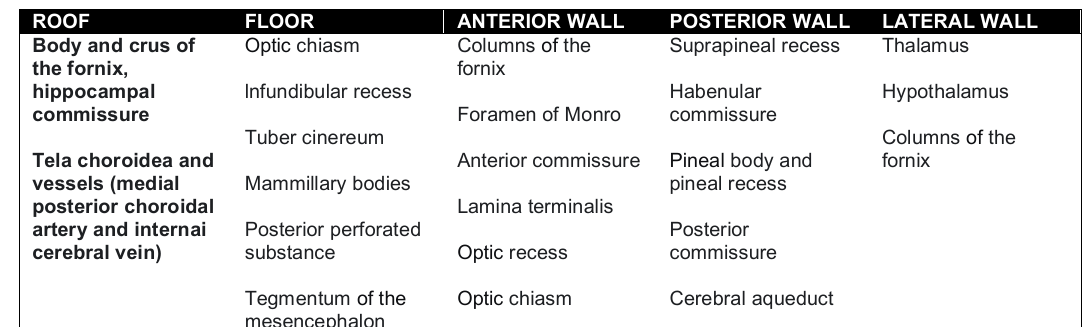
Table 2. Regions and limits of the third ventricle